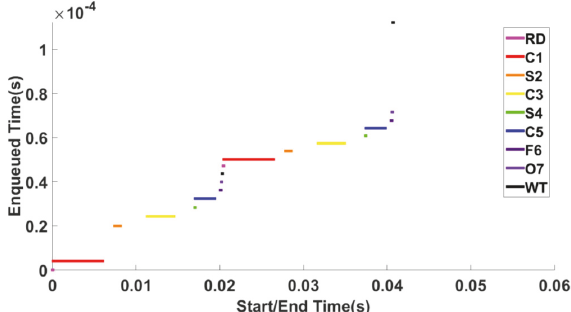
Figure 13: The time distribution without